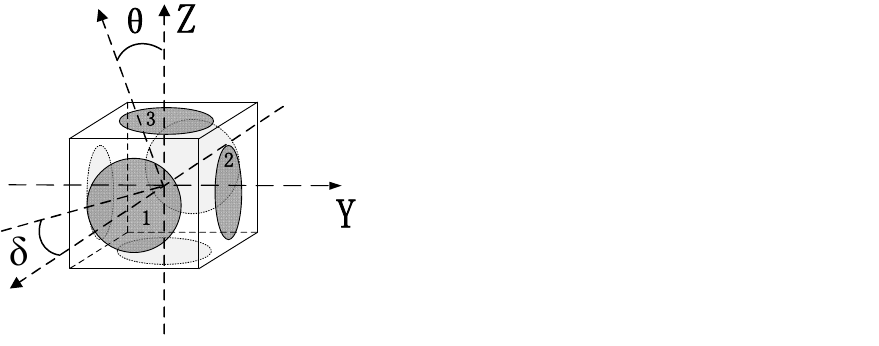
Figure 15. Structure diagram of the three-dimensional electric field measurement system.